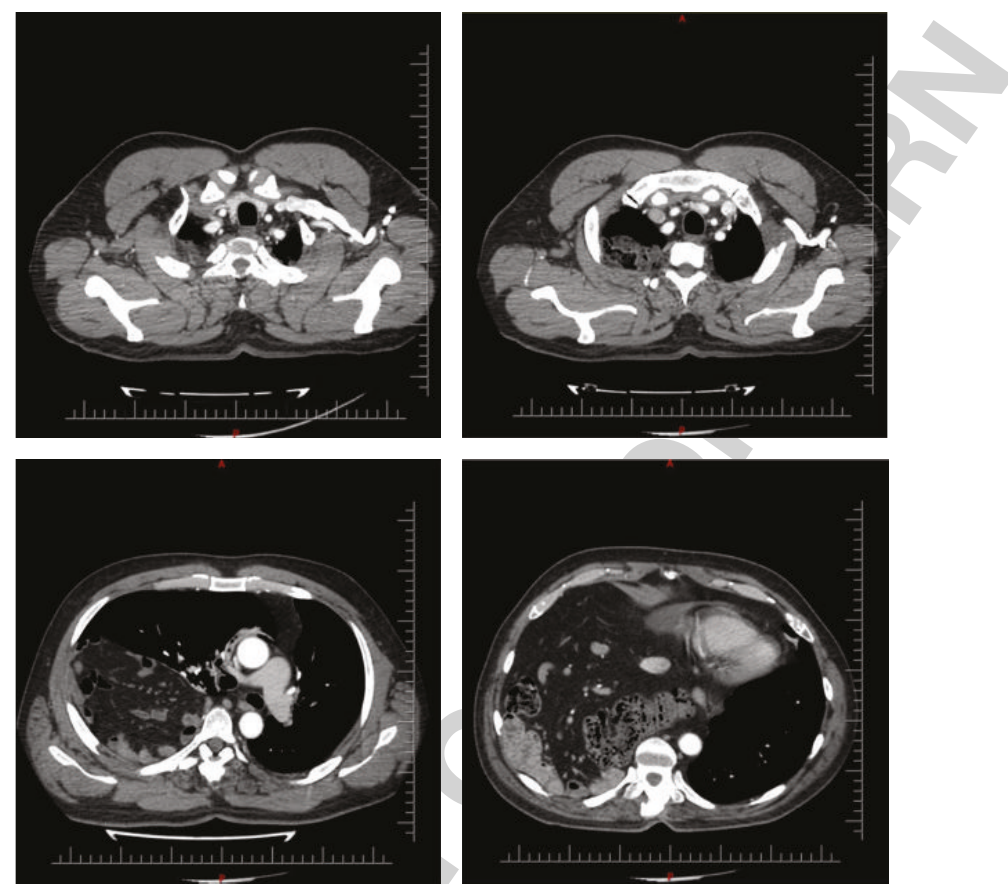
Figure 2: Computerized tomography scan. A defect on the right hemidiaphragm and small bowels, ascending colon, cecum, superior mesenteric artery and branches, pancreas, and duodenum were inside right